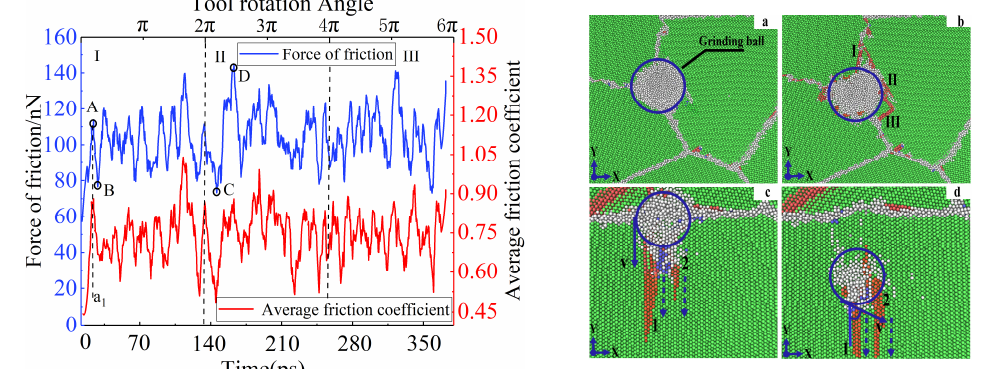
Figure 4. Frictional force and average friction coefficient during friction: a–d corresponding to point A–D in the frictional force curve, ( a ) is the stage of elastic deformation, ( b ) is the stage of plastic deformation, ( c ) is the direction of dislocation slip consistent with velocity, ( d ) is the direction of dislocation slip inconsistent with velocity).